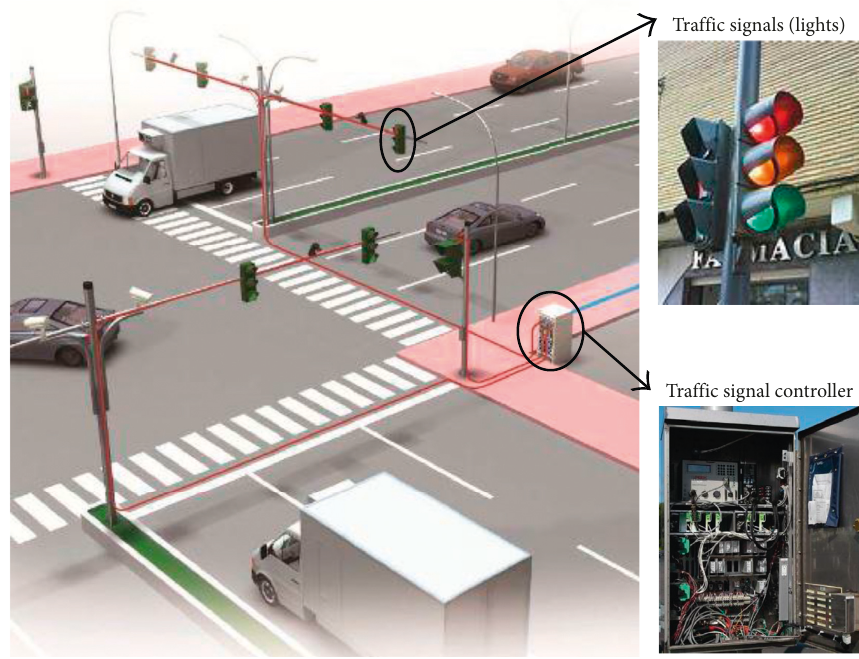
Figure 1: Traffic signals (traffic lights) and a traffic signal